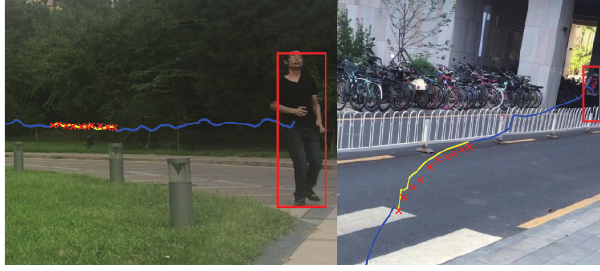
Fig. 5 Trajectory completion